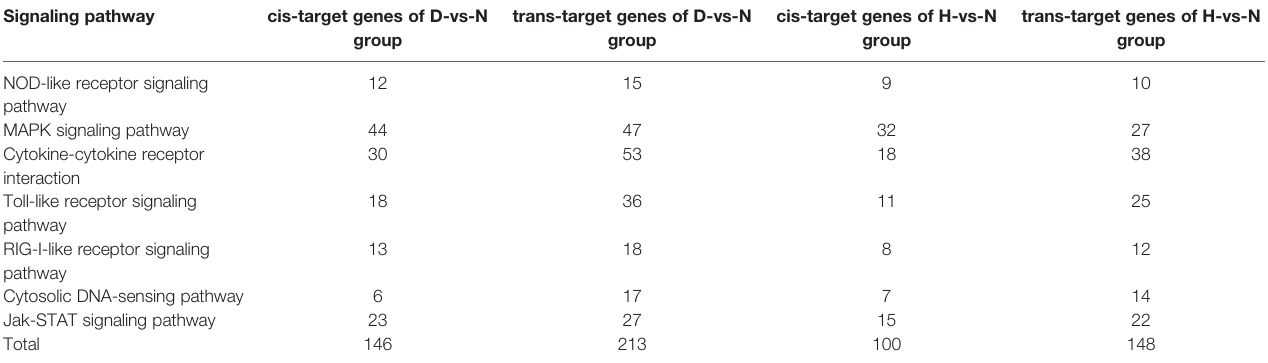
TABLE 3 | The number of the target genes related to innate immunity pathways. Signaling pathway